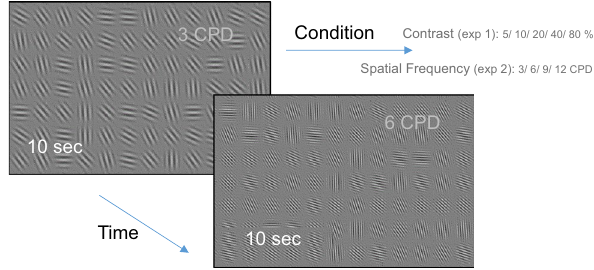
Figure 1. Visual stimuli and the experimental paradigm. Observers free viewed a sequence of full-screen texture images of random orientation Gabor patches for 10-s trial periods. In two separate experiments, the contrast (Exp1) and the spatial frequency (Exp2) were varied across trials in random